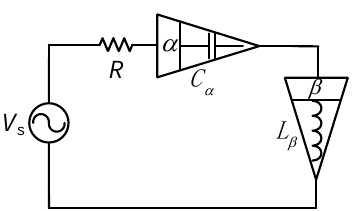
Figure 1. Schematic of fractional-order RL β C α circuit.